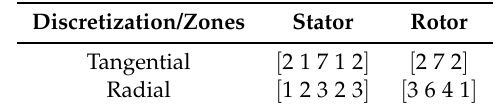
Table 3. Discretization number.